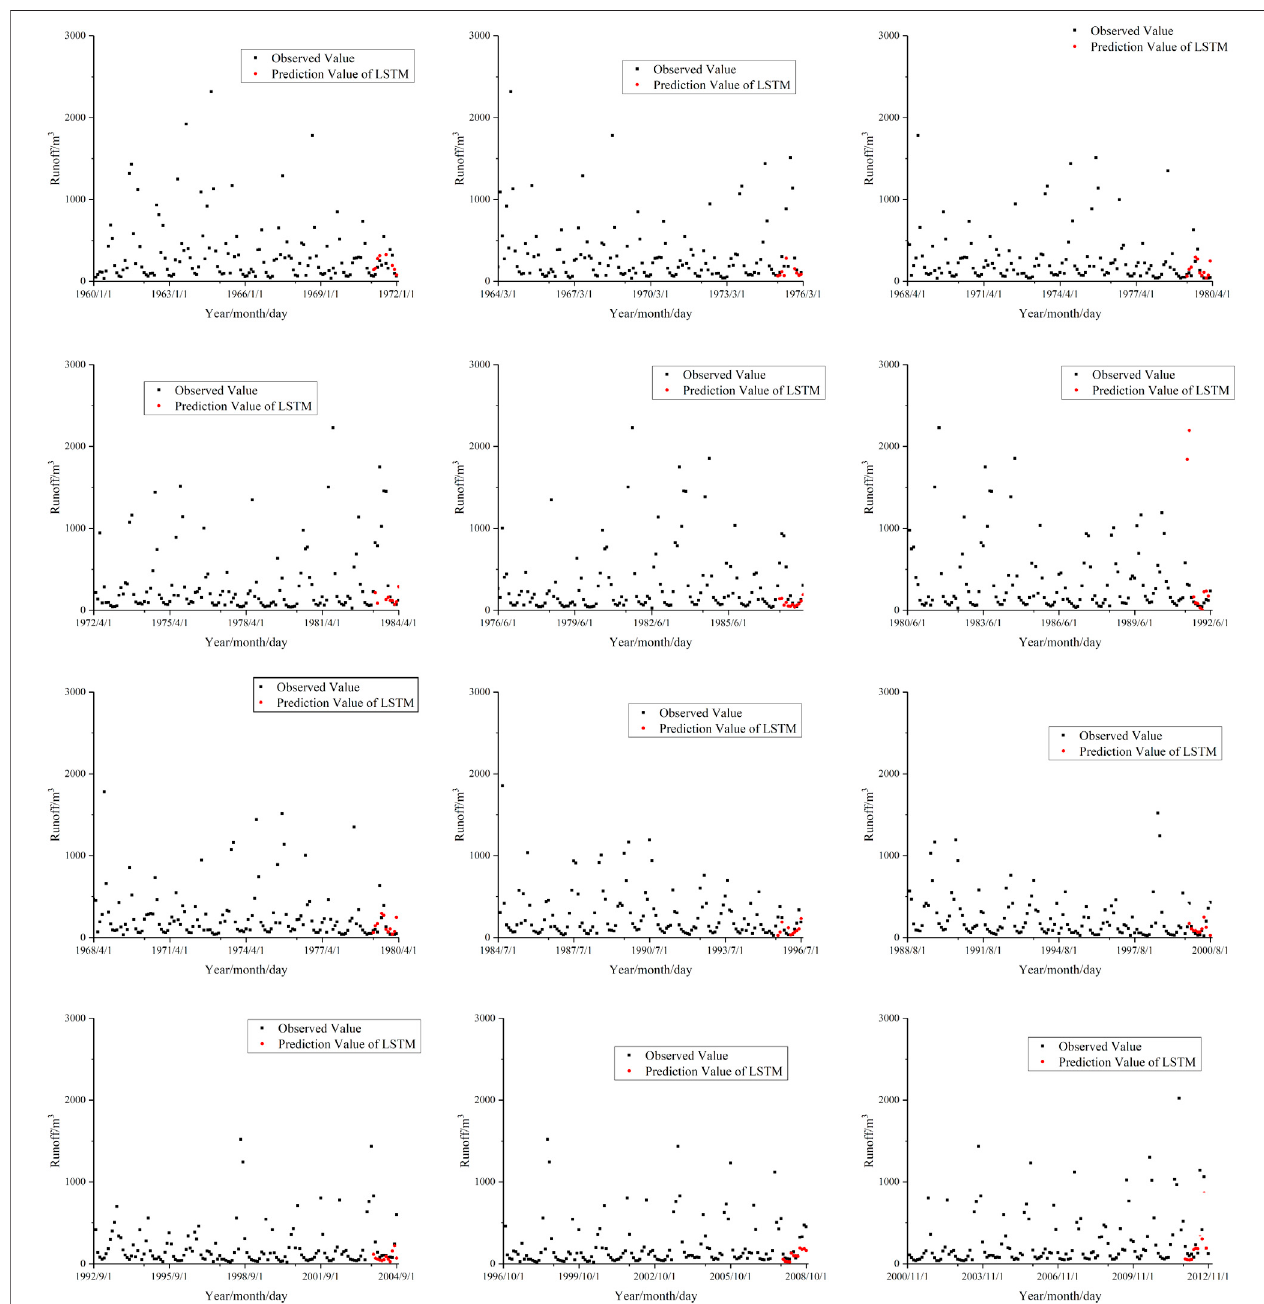
FIGURE 5 | the results of cross-validation based on the LSTM in SQ station